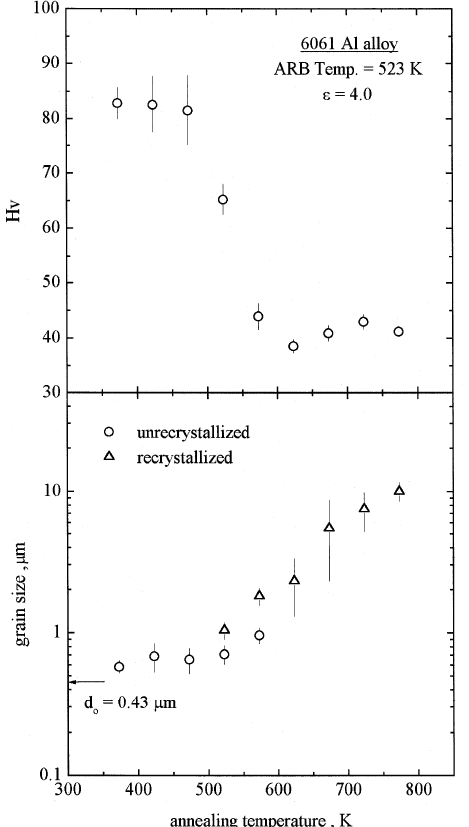
Figure 15. Grain size and microhardness of ARBed 6061 Al alloy under different annealing temperatures [116].